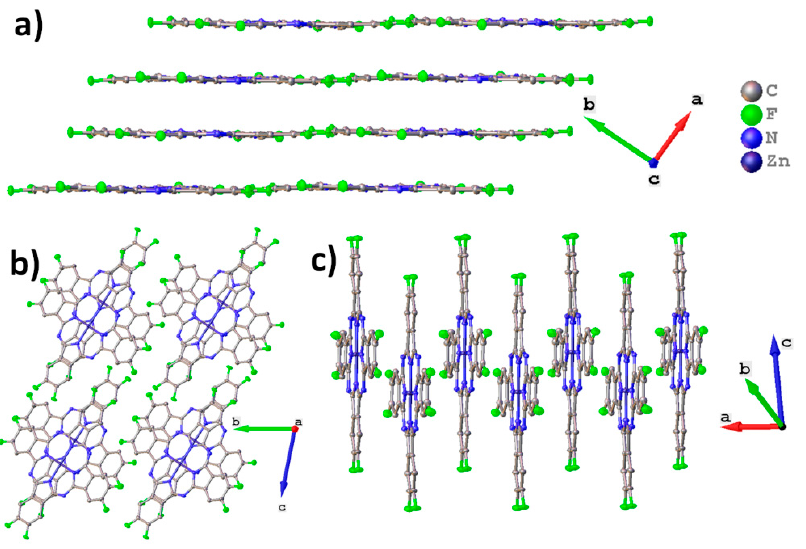
Figure 1. Molecular packing diagrams for ZnPcF 8 : molecular layers along the c axis ( a ), stacks along the a axis ( b ), and arrangement of molecules in an individual stack ( c ).